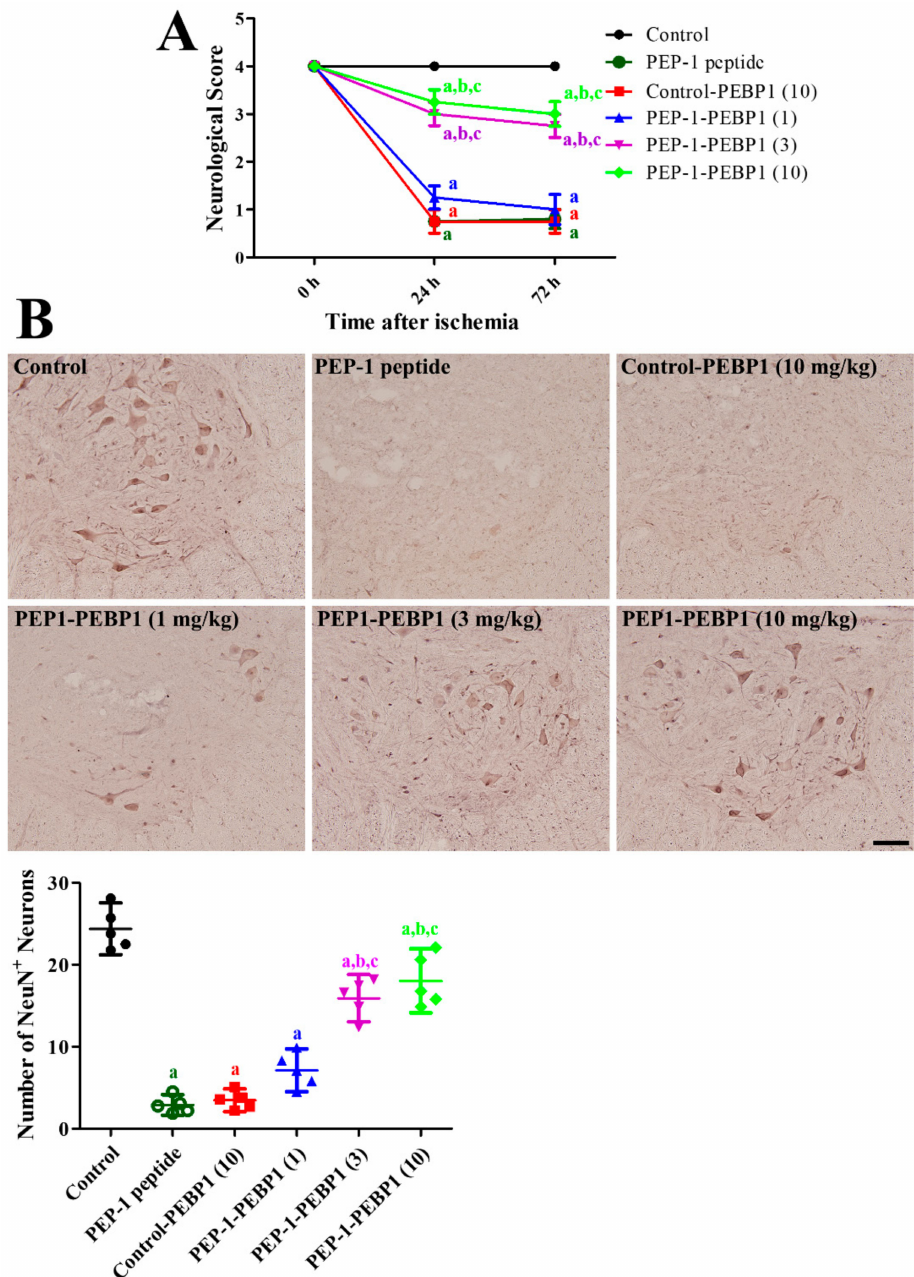
Figure 4. E ff ect of PEP-1-PEBP1 protein against ischemic damage in the rabbit spinal cord. ( A ) Neurological deficits are assessed by Tarlov’s criteria 24 h and 72 h after reperfusion ( n = 10 per group; a p < 0.05, significantly di ff erent from the control group, b p < 0.05, significantly di ff erent from the PEP-1 peptide-treated group; c p < 0.05, significantly di ff erent from the control-PEBP1-treated group). The bars indicate SEM. ( B ) Immunohistochemistry for NeuN to label the surviving neurons in the ventral horn of the spinal cord 72 h after ischemia / reperfusion. The number of NeuN-positive nuclei per section in all the groups is also shown ( n = 5 per group; a p < 0.05, significantly di ff erent from the control group, b p < 0.05, significantly di ff erent from the PEP-1 peptide-treated group; c p < 0.05, significantly di ff erent from the control-PEBP1-treated group). The bars indicate confidence interval or standard errors of